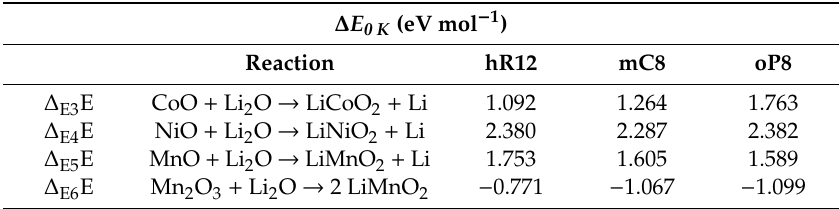
Table 3. Calculated internal energy changes for reactions at 0 K R3-R4-R5-R6 for all the polymorphs (hR12, mC8 and O) of the LCO, LMO and LNO compounds. Energy evaluations involving experimentally reported phases are in